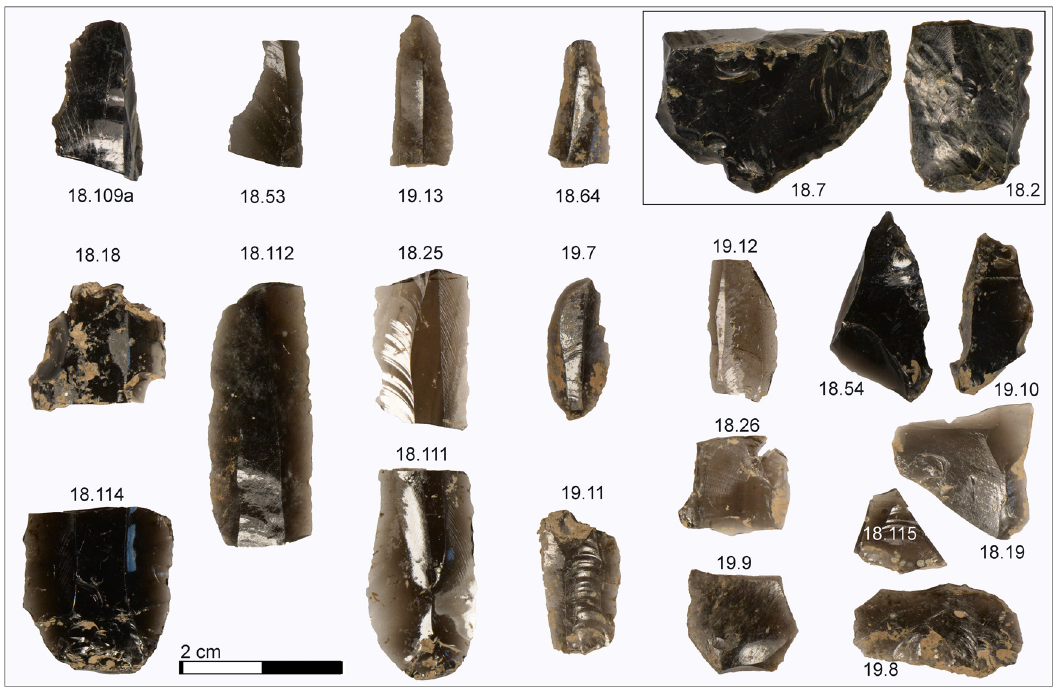
Figure 7: Piano dei Cardoni obsidian assemblage: Selection of 19 artifacts from Lipari source and two from Pantelleria source ( 18.7 and 18.2 )